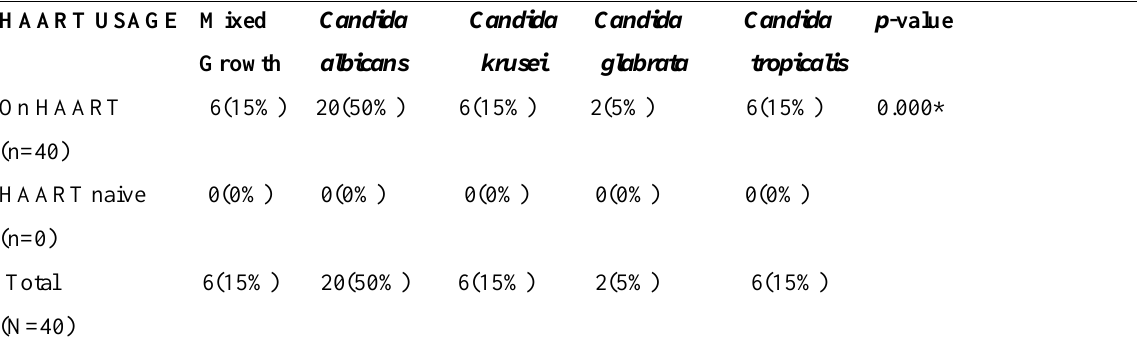
Table 10. Candida species isolated from participant in relation to HAART